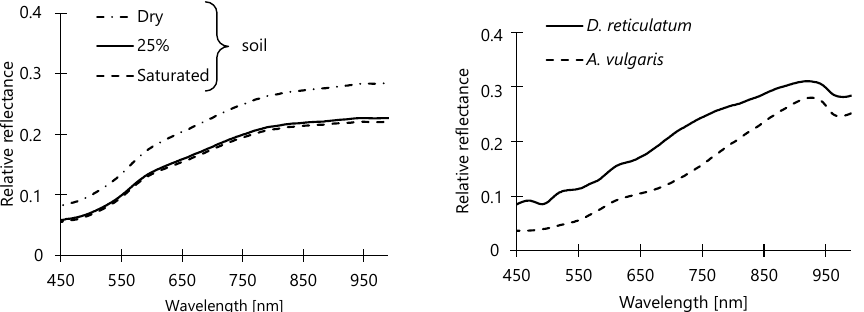
Figure 4. Average of reflectance spectra of soils at different moisture levels ( left ) and slug species ( right ).